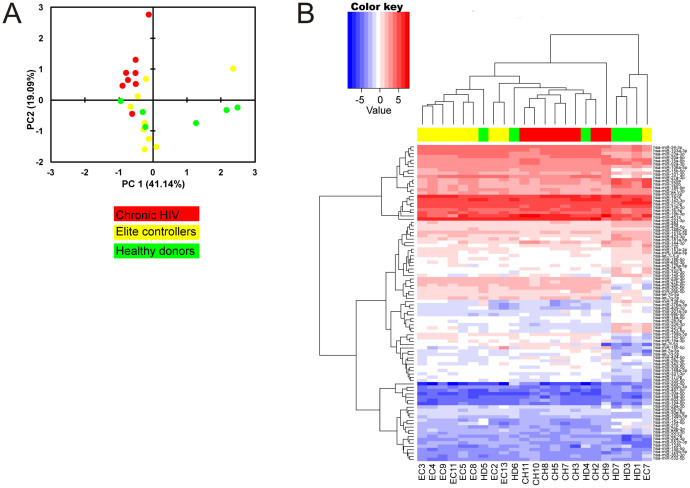
Explorative data analysis.(A) Principal components analysis of miRNAs profile in plasma was done on all miRNAs. The normalized Cp values were used for the analysis. The x-axis corresponds to principal component 1 (PC1) and the y-axis to the principal component 2 (PC2), the percentage of the variance is indicated between brackets. (B) Heatmap and hierarchical clustering. The clustering is performed on all the samples and the 96 miRNAs expressed in all the samples, using complete linkage and Euclidean distance as distance metric. Each column represents one sample and each row one miRNA. The miRNA clustering tree is shown on the left. The color-coded scale (blue: expression levels lower than the mean and red: expression level over the mean) for the normalized expression value is indicated at the top of the figure.